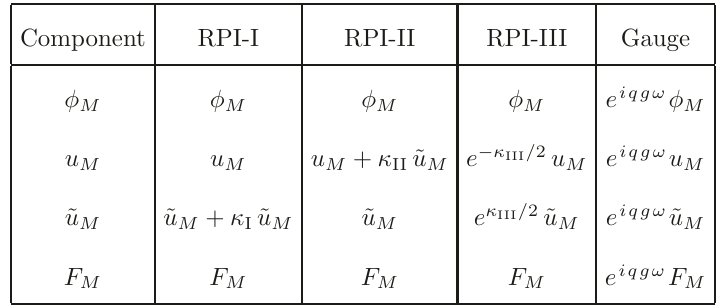
Table 6 . The transformations for the component charged matter